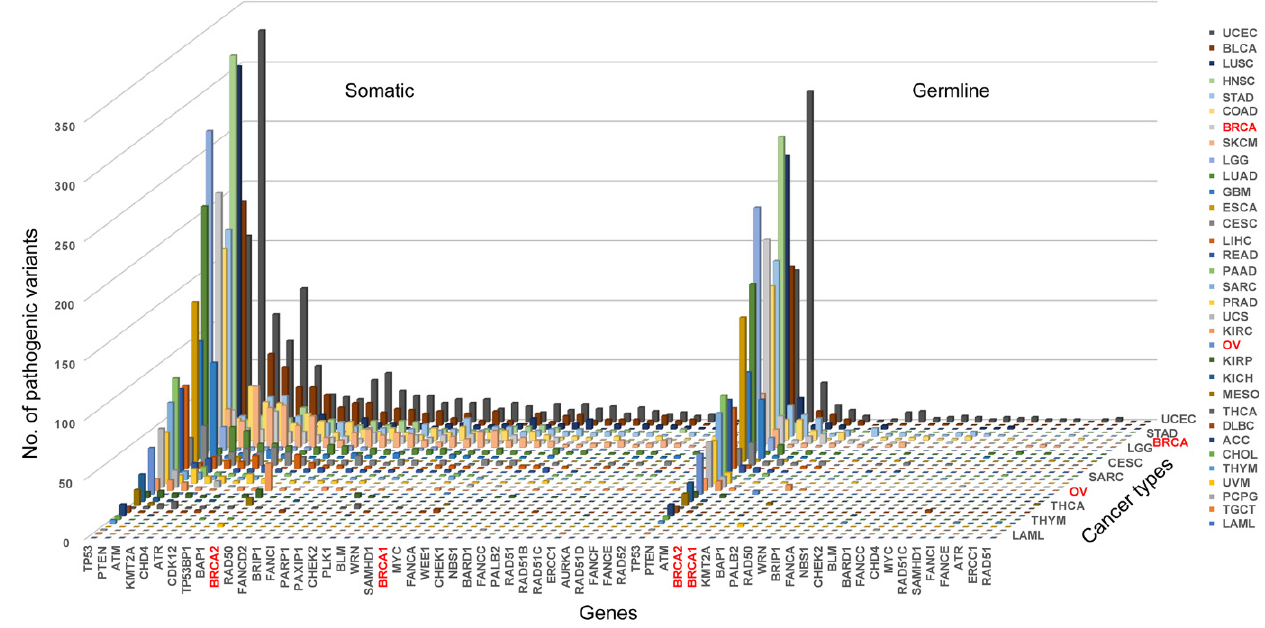
Figure 2. Distribution of pathogenic variation of BRCAness genes in different cancer types. Left part shows the distribution of somatic and right part shows the germline pathogenic variants in BRCAness genes and cancer types. BRCA1 and BRCA2 in red show their corresponding distribution for comparison with BRCAness genes. Abbreviations: ACC, adrenocortical carcinoma; BLCA, bladder urothelial carcinoma; BRCA, breast invasive carcinoma; CESC, cervical squamous cell carcinoma and endocervical adenocarcinoma; CHOL, cholangiocarcinoma; COAD, colon adenocarcinoma; DLBC, lymphoid neoplasm diffuse large B-cell lymphoma; ESCA, esophageal carcinoma; GBM, glioblastoma multiforme; HNSC, head and neck squamous carcinoma; KICH, kidney chromophobe; KIRC, kidney renal clear cell carcinoma; KIRP, kidney renal papillary cell carcinoma; LAML, acute myeloid leukemia; LGG, brain lower grade glioma; LIHC, liver hepatocellular carcinoma; LUAD, lung adenocarcinoma; LUSC, lung squamous cell carcinoma; MESO, mesothelioma; OV, ovarian serous cystadenocarcinoma; PAAD, pancreatic adenocarcinoma; PCPG, pheochromocytoma and paraganglioma; PRAD, prostate adenocarcinoma; READ, rectum adenocarcinoma; SARC, sarcoma; SKCM, skin cutaneous melanoma; STAD, stomach adenocarcinoma; TGCT, testicular germ cell tumors; THCA, thyroid carcinoma; THYM, thymoma; UCEC, uterine corpus endometrial carcinoma; UCS, uterine carcinosarcoma; UVM, uveal melanoma.